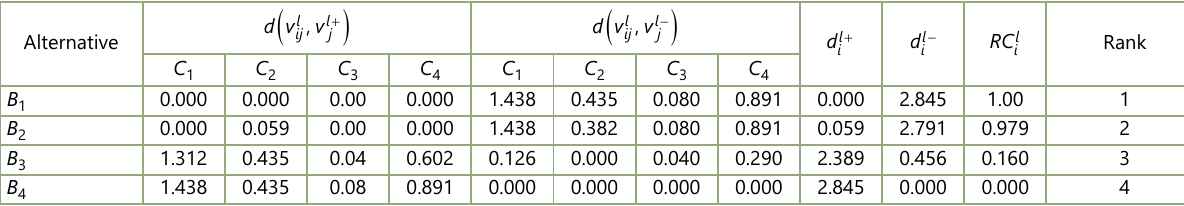
Table 18. The distances from the ideal and anti-ideal solutions with calculated rank indicator for standard products ( l = 1) (source: own contribution)